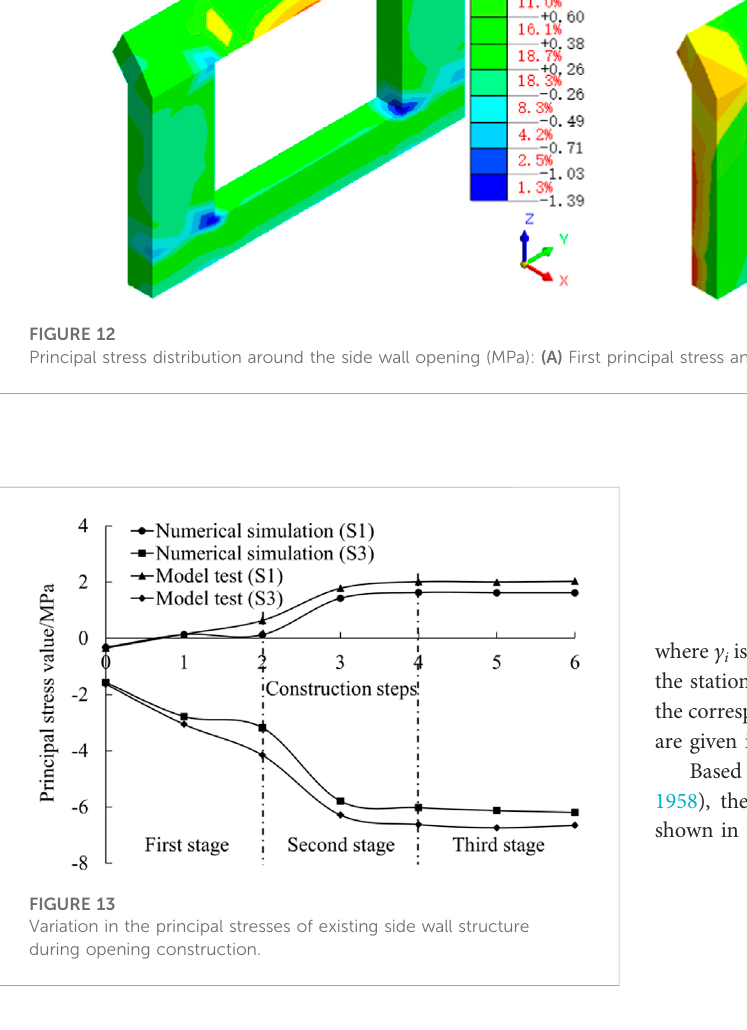
Frontiers in Earth